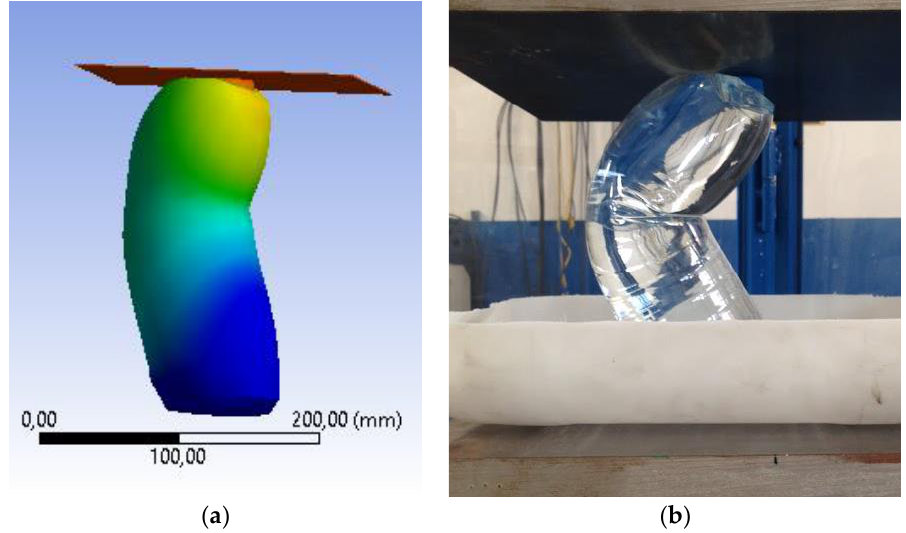
Figure 15. Effect of a top-load test with 90 mm forced displacement: simulation ( a ) of deformations in